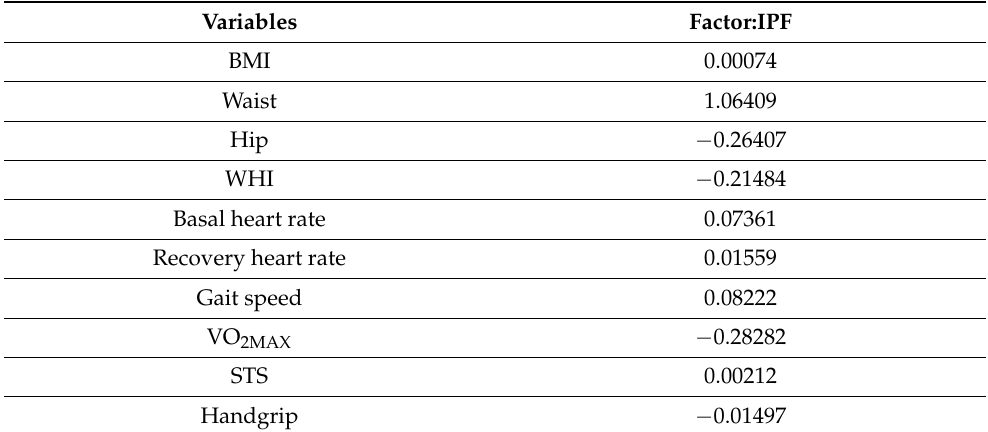
Table 1. IPF and contributing variables: factor